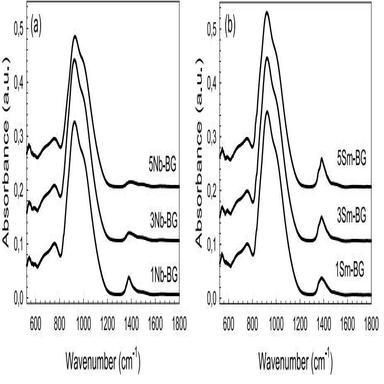
FTIR spectra of the as-prepared (a) Nb5+, (b) Sm3+-substituted bioactive glass powders.